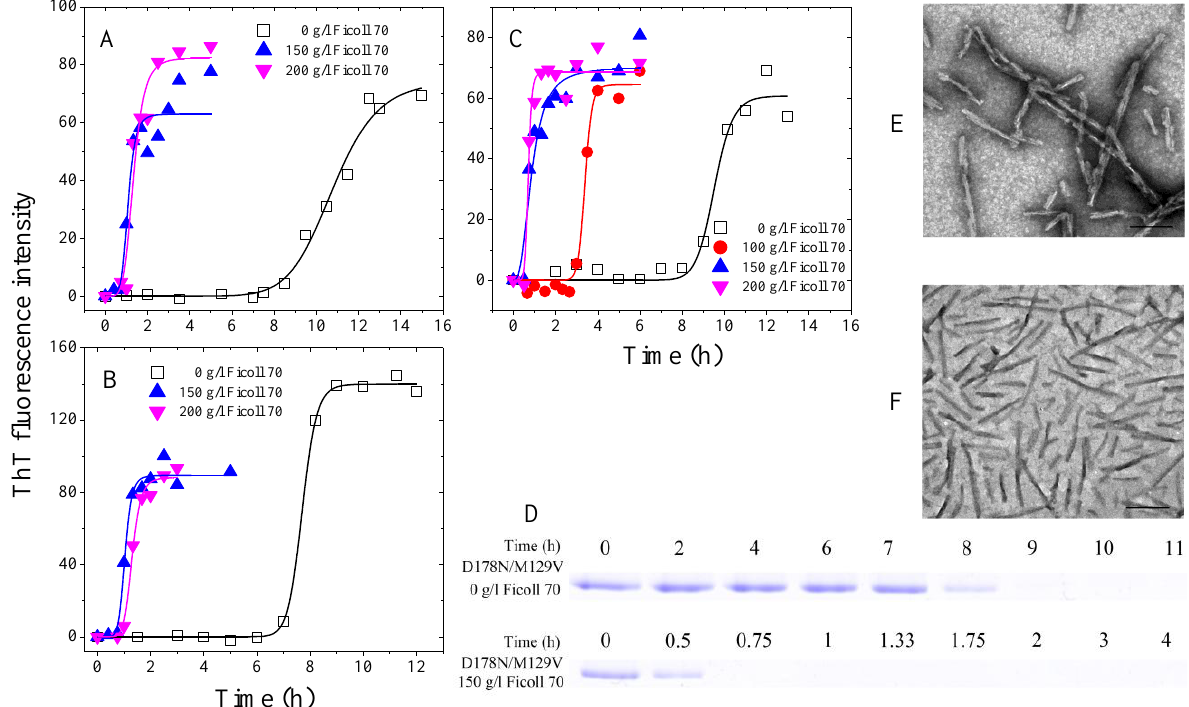
Figure 1. Macromolecular crowding enhances fibril formation of the recombinant human prion protein double mutants E196K/E219K ( A ), Q217R/E219K ( B ), and D178N/M129V ( C – F ). Fibril formation of pathogenic mutants in the absence and in the presence of Ficoll 70, monitored by ThT fluorescence ( A – C ) and Sarkosyl-soluble SDS-PAGE ( D ). In ThT fluorescence assay ( A – C ), 10 μM human PrP mutant was incubated at 37 °C in PBS buffer (pH 7.0) containing 2.0 M guanidine hydrochloride in the absence and presence of a crowding agent with continuous shaking at 220 rpm. The empirical Hill equation was fitted to the data and the solid lines represented the best fit. The crowding agent concentrations were 0 ( open square ), 100 g/L ( solid circle ), 150 g/L ( solid triangle ), and 200 g/L ( inverted solid triangle ), respectively. The assays were carried out at 37 °C. In Sarkosyl-soluble SDS-PAGE experiments ( D ), 20 μM D178N/M129V was incubated under the same condition described above. Samples were taken and dialyzed against 20 mM sodium acetate buffer, and incubated with 100 mM Tris-HCl buffer containing 2% Sarkosyl for 30 min. Then the samples were centrifuged at 17,000 g for 30 min and the supernatants were mixed with 2× loading buffer and separated by 13.5% SDS-PAGE. Gels were stained with Coomassie Blue R250. Transmission electron micrographs of D178N/M129V were made after incubation under different conditions ( E and F ). D178N/M129V samples were incubated for 11 h ( E ) or 2 h ( F ) in the absence of a crowding agent ( E ) and in the presence of 150 g/L Ficoll 70 ( F ), respectively. A 2% ( w/v ) uranyl acetate solution was used to negatively stain the fibrils. The scale bars represent 200 nm.